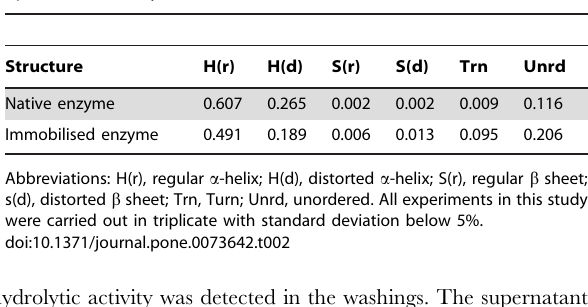
Table 2. Fractions of each type of secondary structure in lipase covalently immobilised to amino-functionalised MWNT.